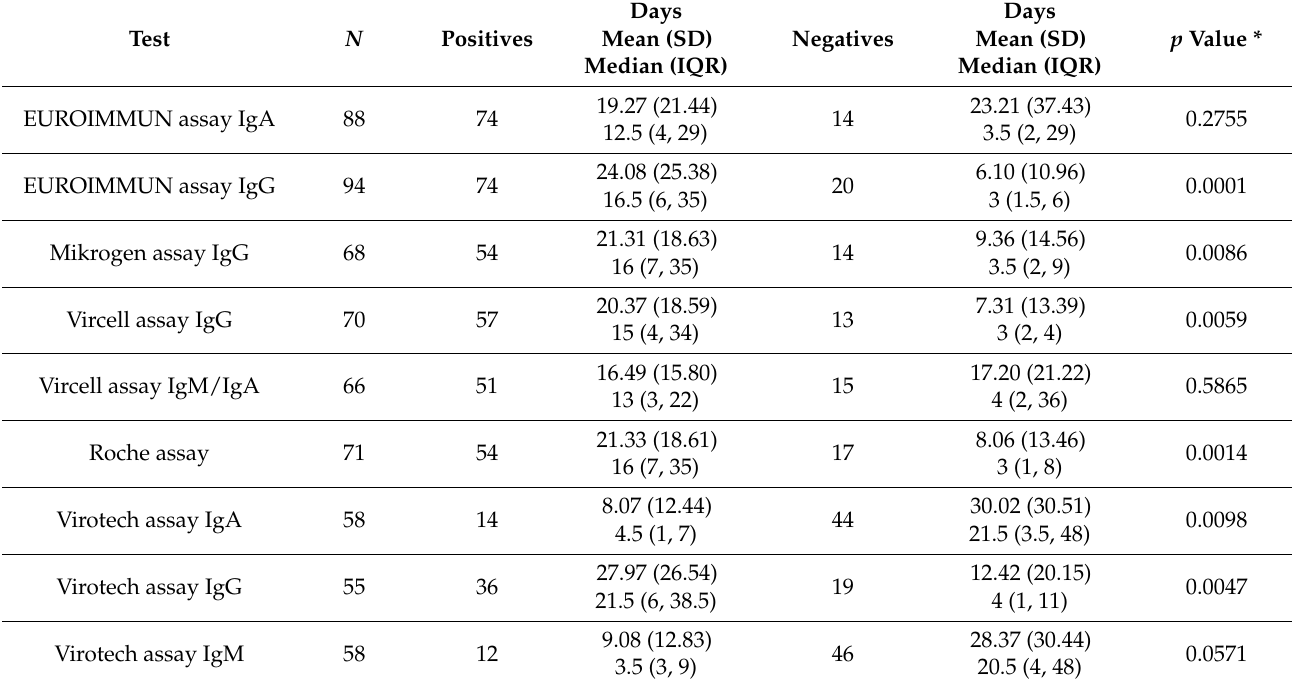
Table 2. Comparison of the time (in days) between positive PCR results and serum sample acquisition of the different assays.